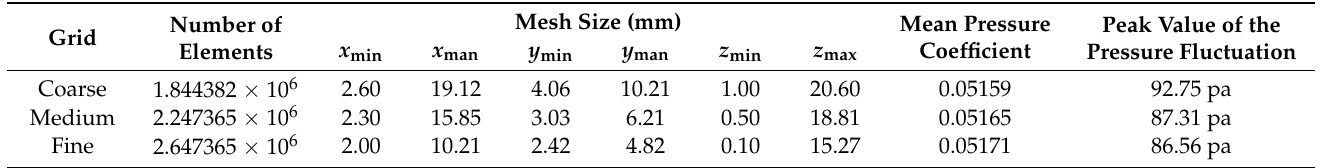
Table 1. Mean pressure coefficient and peak value of the pressure fluctuation for monitor point